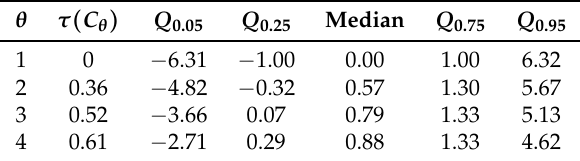
Table 11. Some percentiles of Y = X 1 / X 2 , where ( X 1 , X 2 ) follows Joe Copulas.